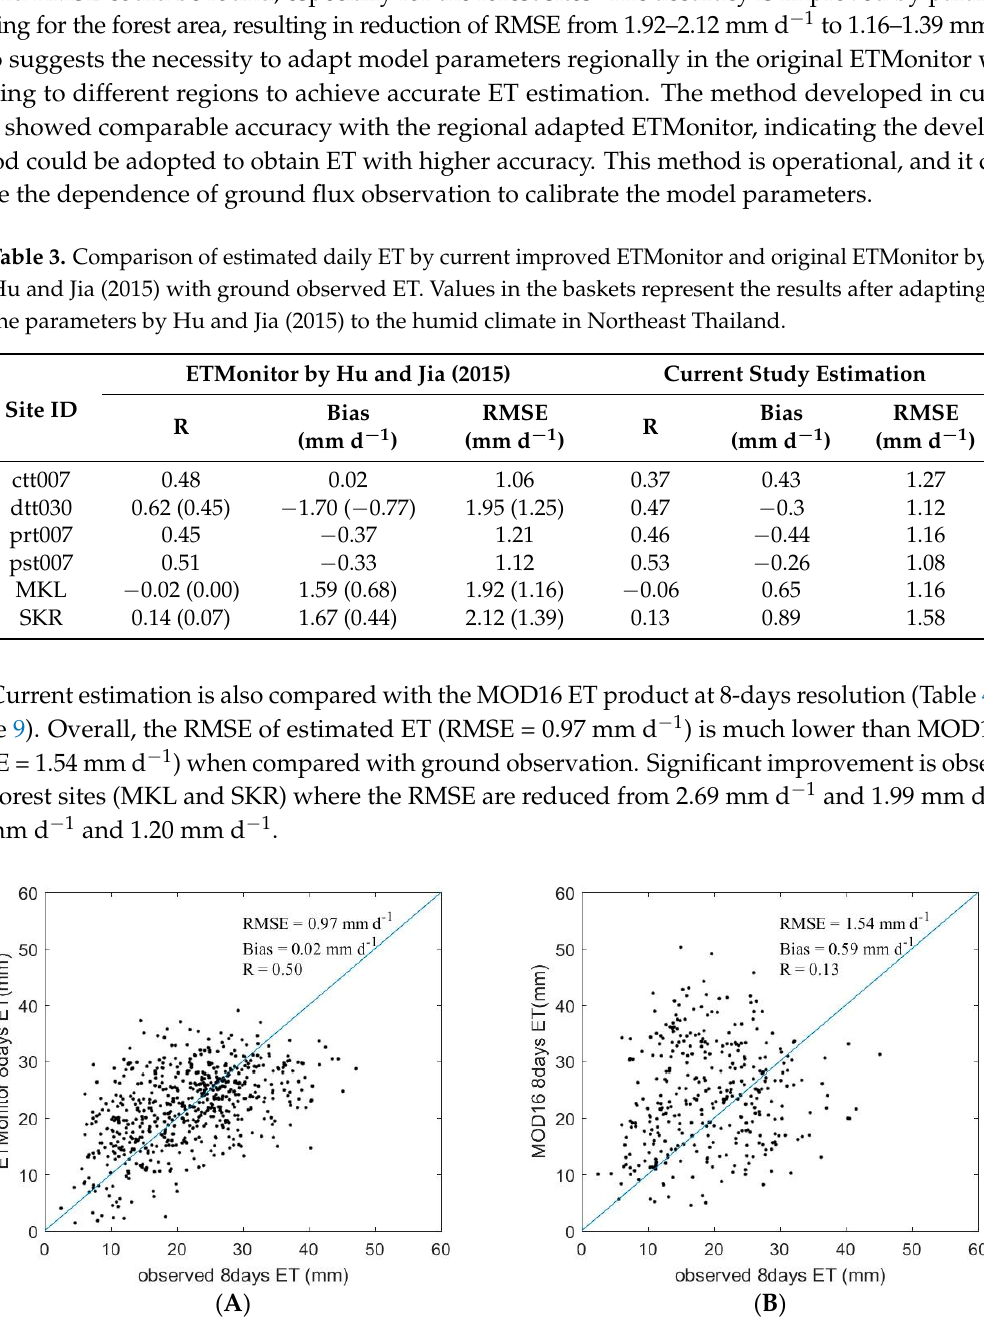
Figure 9. Comparison of ( A ) ETMonitor estimated 8 days ET in current study and ( B ) MOD16 ET with ground observed ET. Table 4. Comparison of ETMonitor estimated 8 days ET and MOD16 8 days ET with ground observed ET.